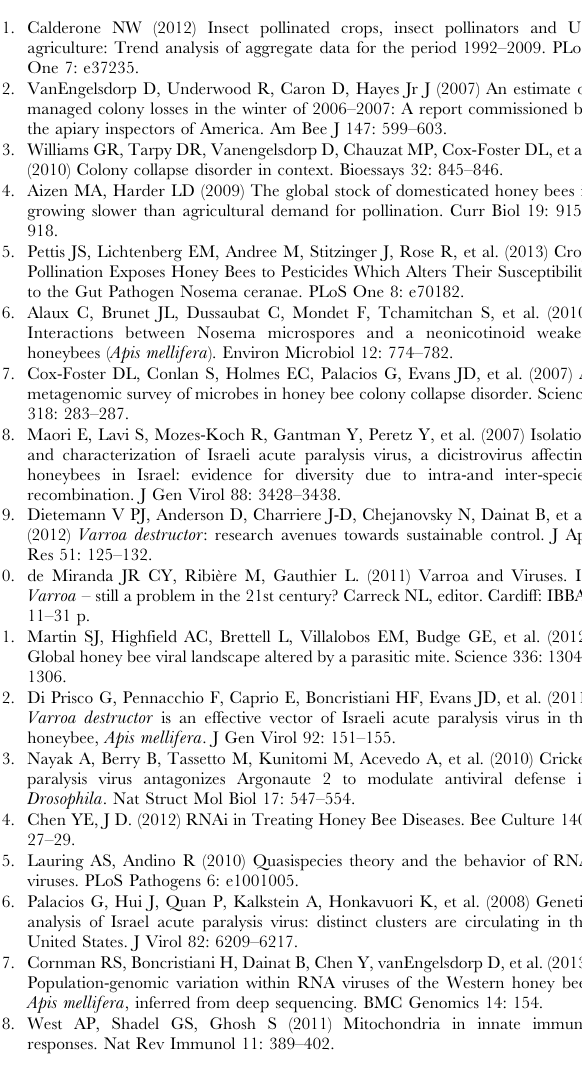
represents one gene with detectable expression. The horizontal line marks the threshold ( p # 0.05, adjusted using the Benjamini & Hochberg false discovery rate) for defining genes with altered expression. The vertical lines represent change $ 1.5 fold in expression and define genes as up-regulated (right) or down- regulated (left). (TIF) Table S1 Functional annotation clustering of activated genes in response to IAPV infection in adults. (XLSX) Table S2 Functional annotation clustering of activated genes in response to IAPV infection in brood.